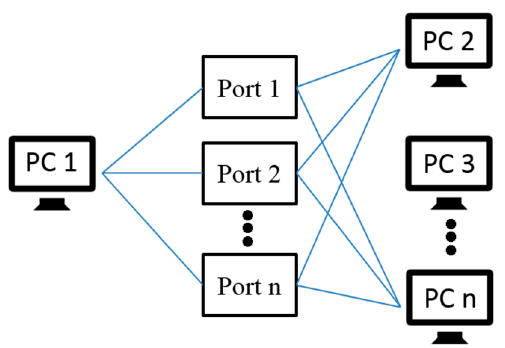
Figure 5. The diagram block scanning schematic.